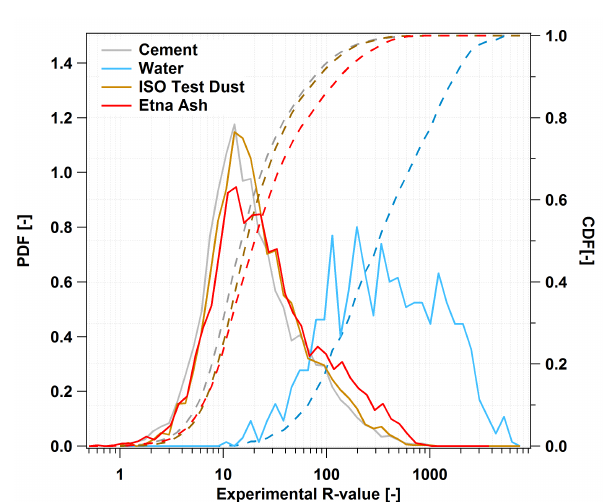
Figure 6. Measured probability density functions (left axis, solid lines) and cumulative density functions (right axis, dashed lines) of R values for water droplets and different dust-like